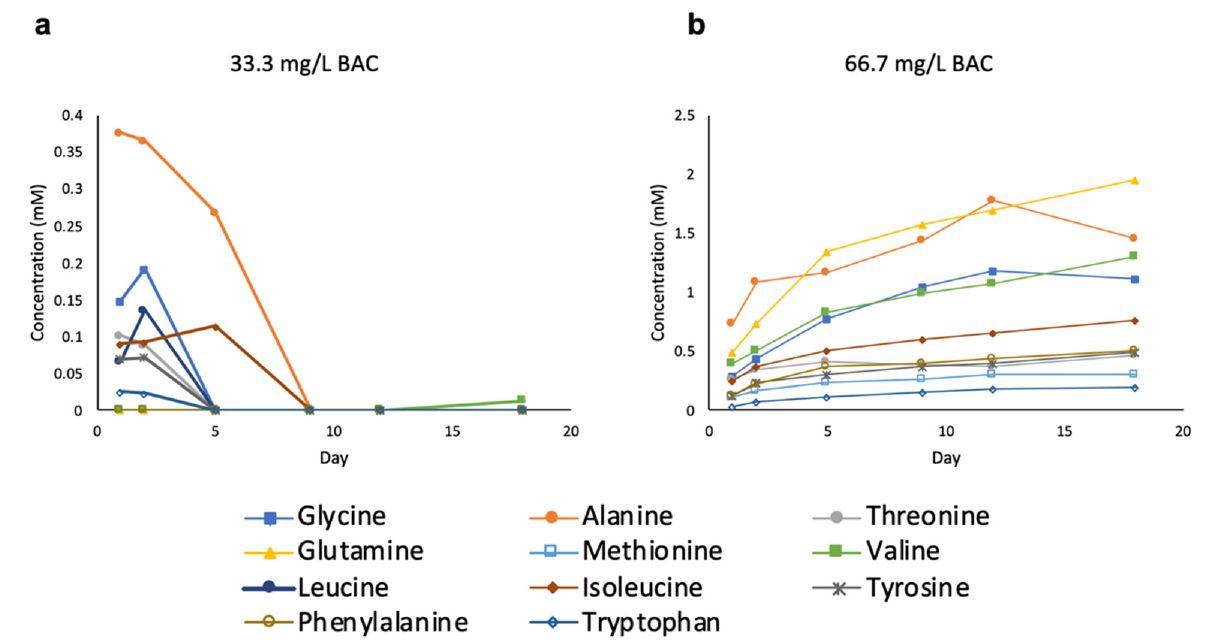
Figure 7. Changes in selected amino acid concentrations in the microcosms exposed to BAC as meas- ured using 1 H NMR spectroscopy for ( a ) 33.3 mg/L BAC and ( b ) 66.7 mg/L BAC.